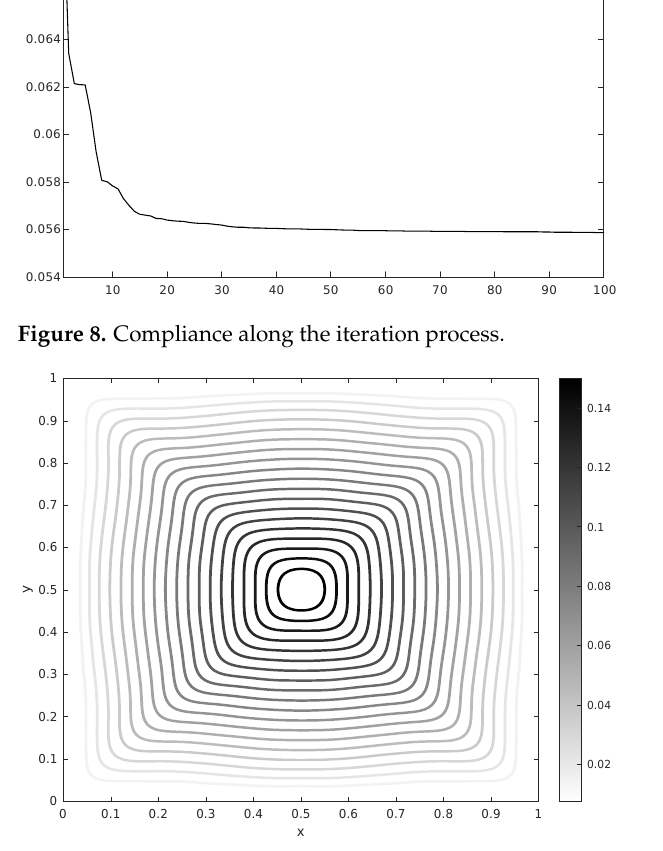
Figure 9. Approximation of the optimal Figure 9: Approximation of the optimal estate